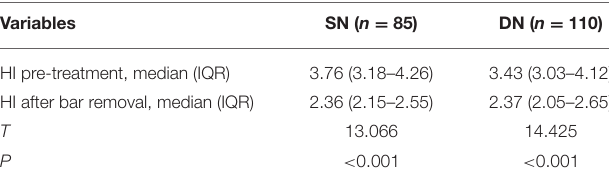
TABLE 3 | HI pre-treatment and HI after bar removal in SN and DN groups.